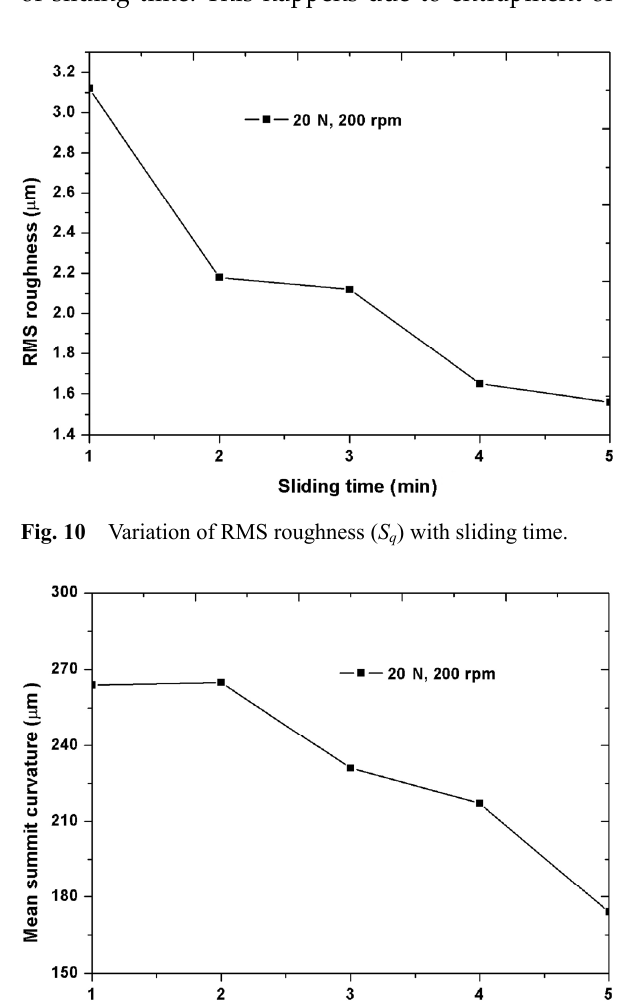
Fig. 12 Variation of autocorrelation length ( S al ) with sliding